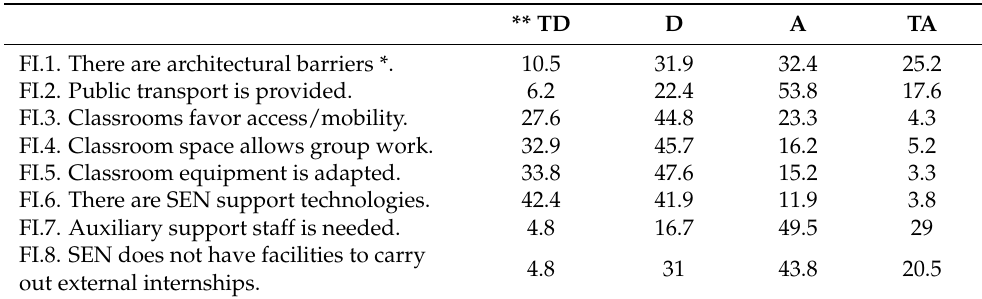
Table 4. Factor I. Accessibility and resources that universities have in order to facilitate inclusion (percentage of responses).